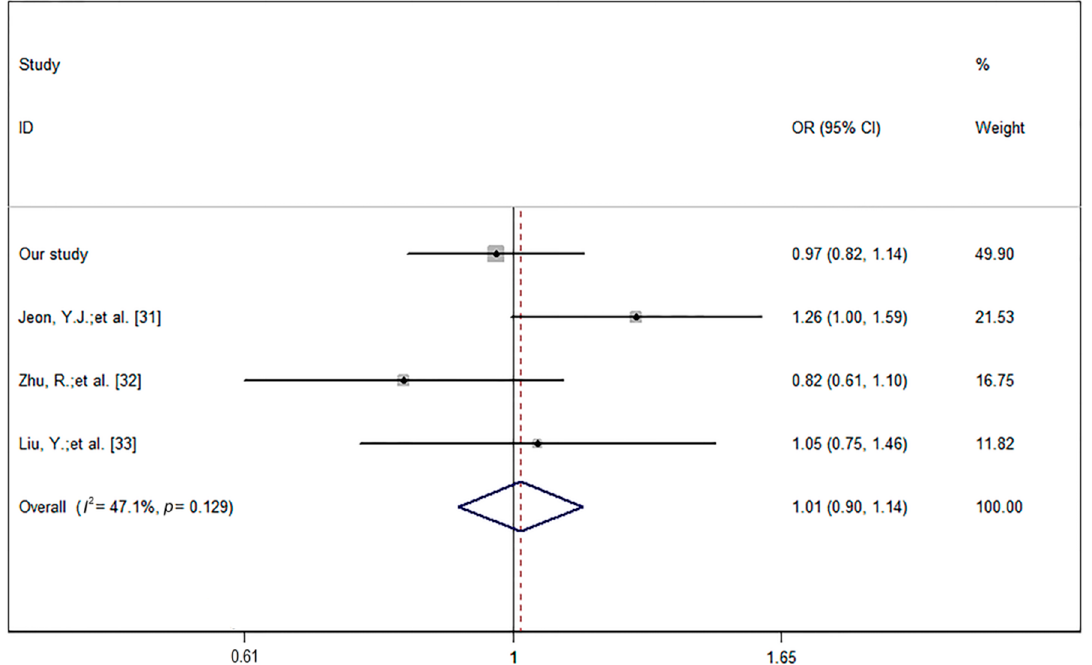
Figure 1. Forest plot showed the relationship between rs2910164 and ischemic stroke in Asian populations (four studies) under the dominant model (genotype (GG + CG) vs. CC). Heterogeneity: χ 2 = 5.67, p = 0.129, I 2 = 47.1%.